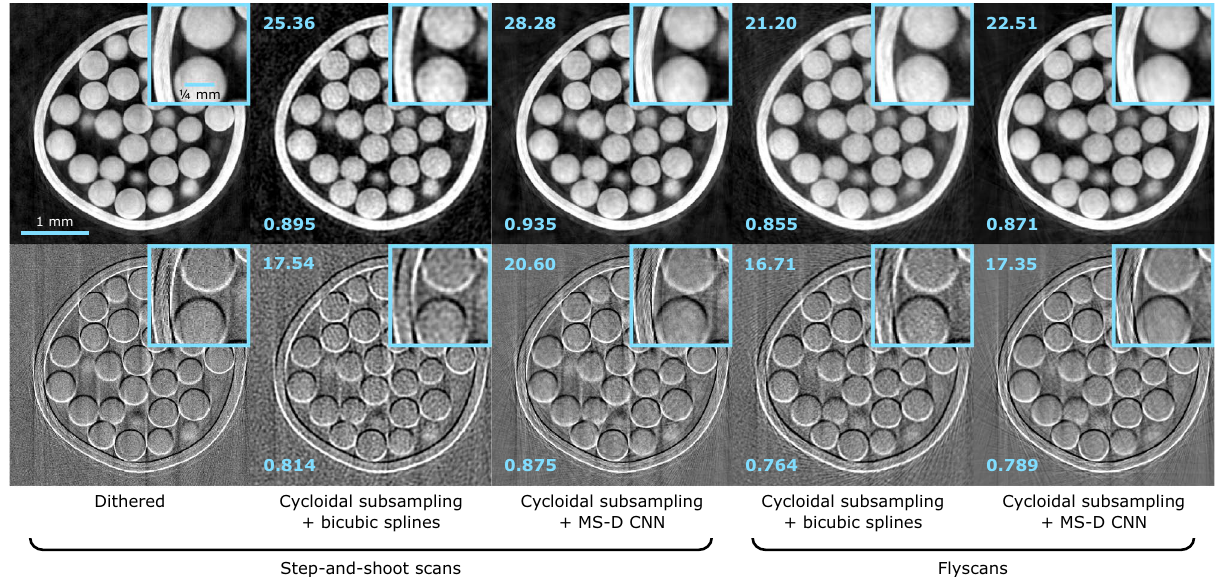
Figure 9. Tomographic images of 425–500 µ m diameter polyethylene spheres (phase contrast acquisition). From left to right: images reconstructed from complete (i.e. dithered; step-and-shoot) sinograms, cycloidal sinograms interpolated with bicubic splines (step-and-shoot), cycloidal sinograms processed with the MS-D CNN (step-and-shoot), cycloidal sinograms interpolated with bicubic splines (flyscan) and cycloidal sinograms processed with the MS-D CNN (flyscan). The top row shows phase retrieved images, while the bottom row shows what these images would look like if phase retrieval were not applied. The PSNR (top left) and MS-SSIM (bottom left) with respect to the dithered images are shown for each low-dose